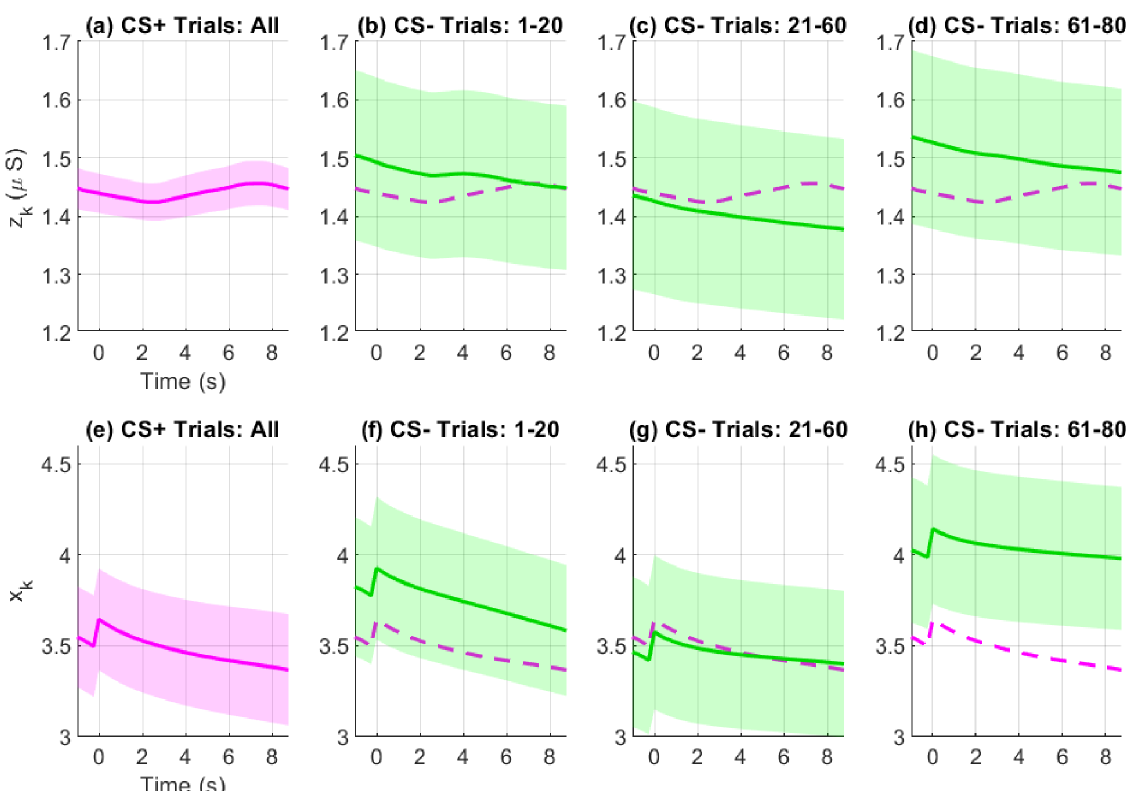
Fig 12. Variation of the averaged skin conductance and state estimates across trials for participant 2. Sub-panels (a) and (e) show the averaged skin conductance ( z k ) and arousal ( x k ) estimates for all CS+US- trials. Sub-panels (b)-(d) and (f)-(h) show the variation of the averaged skin conductance and arousal estimates for the CS- trials across trial blocks 1-20, 21-60 and 61-80. For z 1-20 to 21-60. However, there is an increase from 61-80. The same pattern is visible for x k . However, the gap is much larger for x k in trials 61- 80. Therefore when averaged across all blocks, the relative positions of the CS+US- and CS- are interchanged (Fig 8).